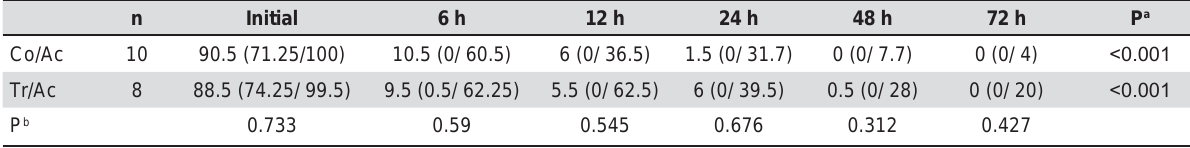
a Friedman test b Mann-Whitney U test